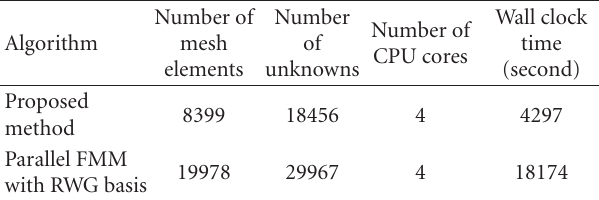
Figure 8: RCS results on XOY plane of Y-8 aircraft at 100MHz. Table 2: Comparison between the proposed and FMM